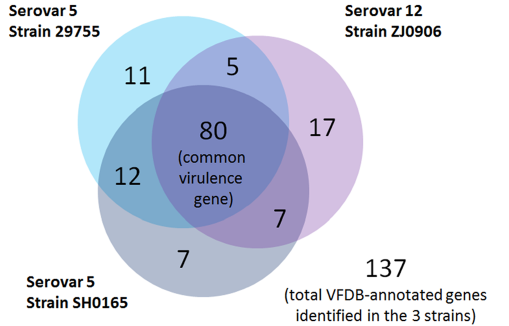
Figure 5. Common VFDB-annotated genes between H.parasuis strains ZJ0906, SH0165 and 29755. The Venn diagram was not drawn in proportion and aims only for illustration of the common VFDB- annotated genes shared between the 3 strains. Circles denote the panel of VFDB-annotated genes in the three strains, overlapping region between circles denote genes shared with respective strains. Numeral figures within respective regions denote the number of genes found